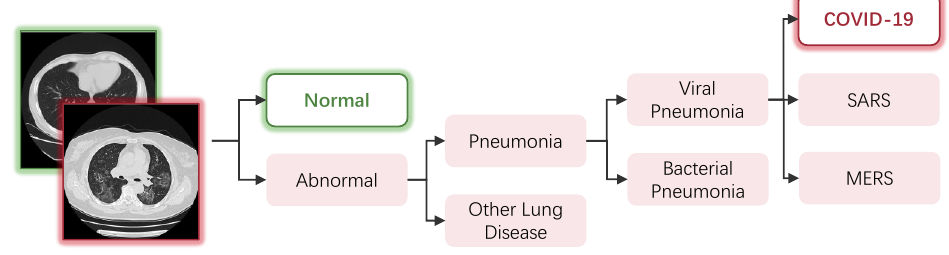
Figure 6. An example of the hierarchical relationships of different lung